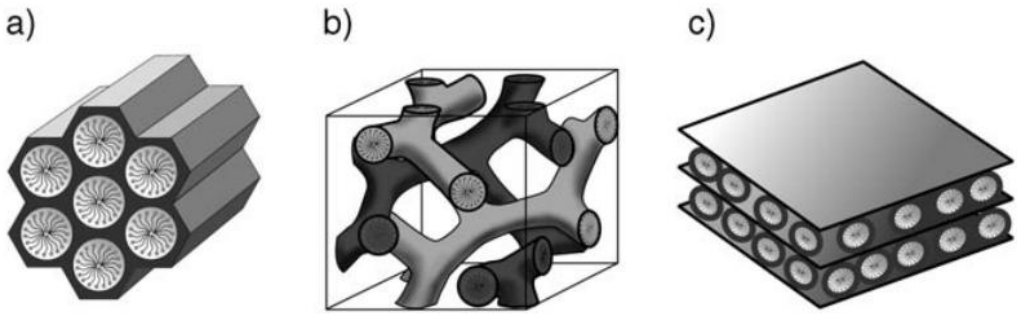
Figure 12. Structures of mesoporous M41S materials: ( a ) MCM-41 (2D hexagonal, p6mm); ( b ) MCM-48 (3D cubic, Ia3d); and ( c ) MCM-50 (lamellar, p2). Reproduced from Ref. [107], Copyright 2006, John Wiley and Sons.